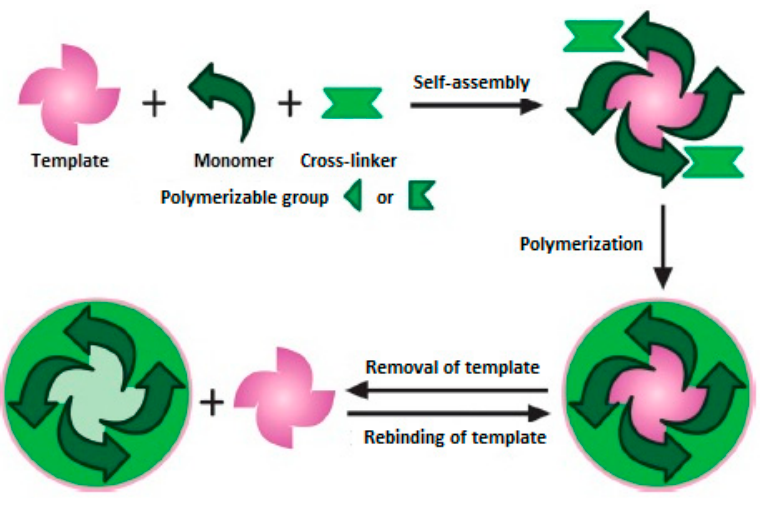
Figure 1. Schematic representation of molecular imprinting (reproduced with permission from [11]).